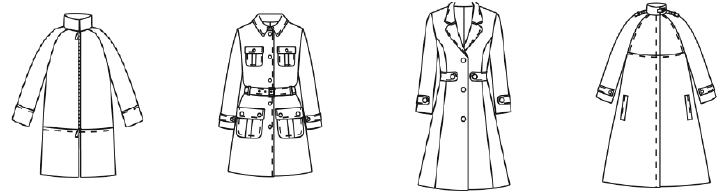
Figure 4. Sample cutting illustration. Table 2. Female coat design elements.